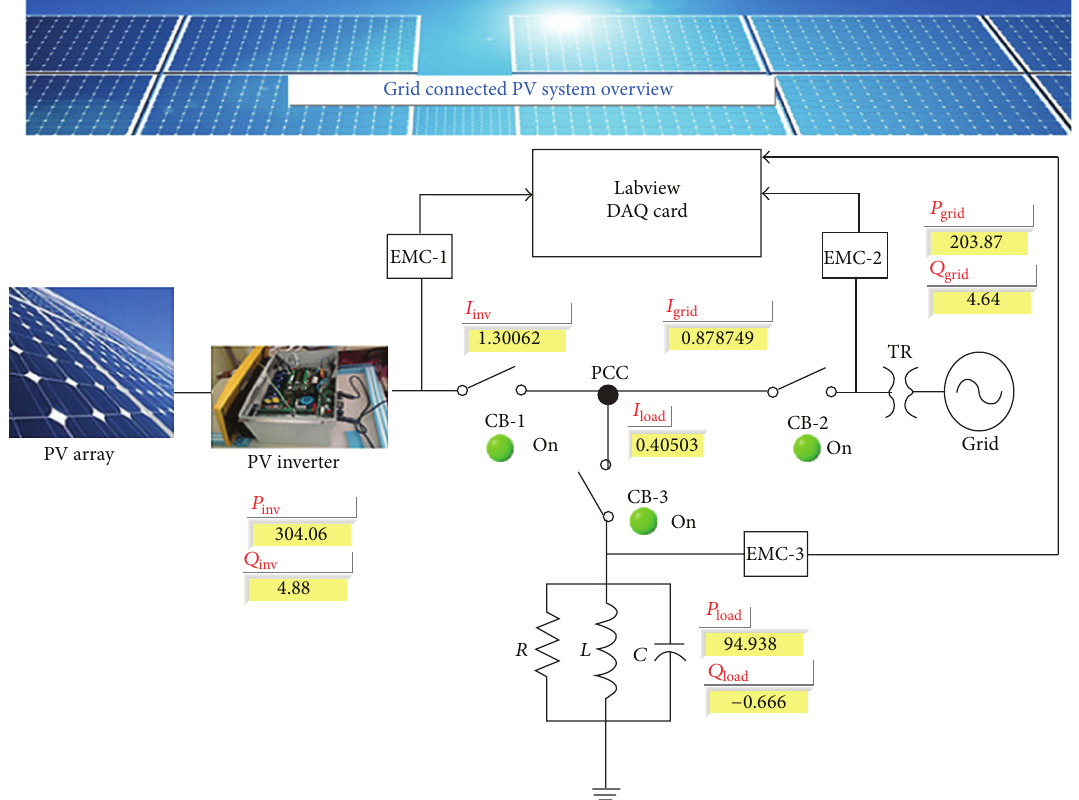
Figure 17: Grid tied PV system with developed software interface.